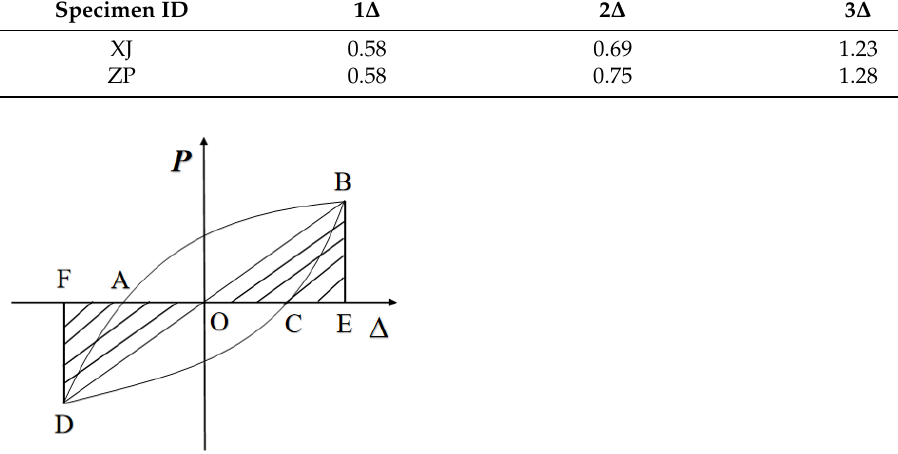
Figure 12. Graphical representation of energy dissipation coefficient calculation. Table 5. Energy dissipation coefficients of specimens XJ and ZP.